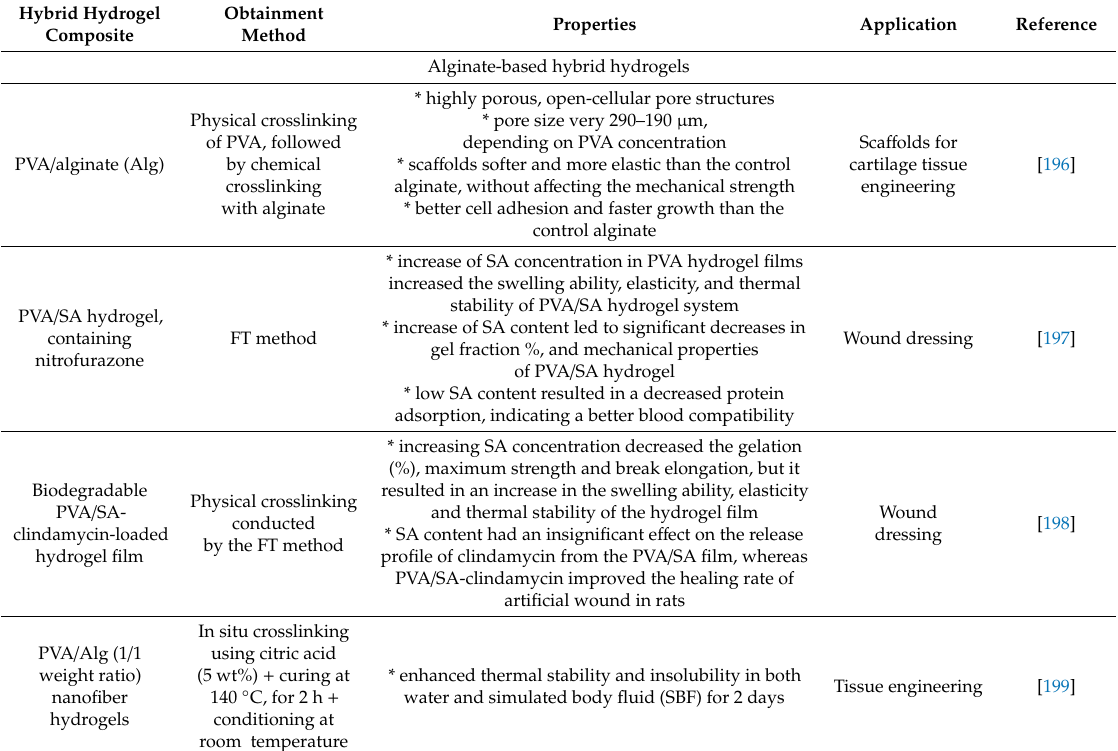
Table 3. Heteropolysaccharide-based hybrid hydrogel systems with biomedical